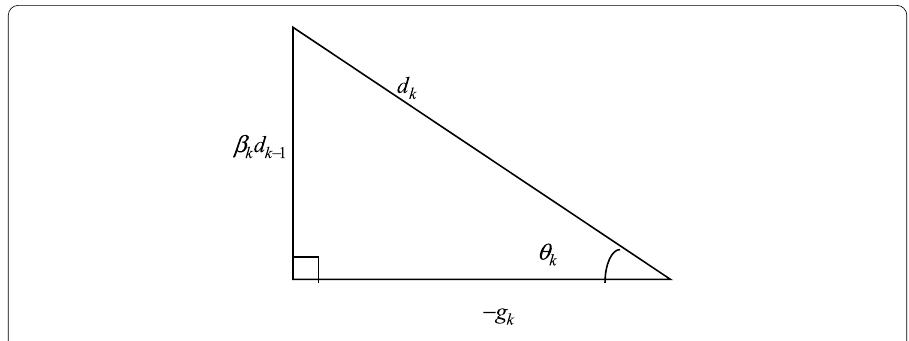
Figure 3 The angle between the negative gradient and the search